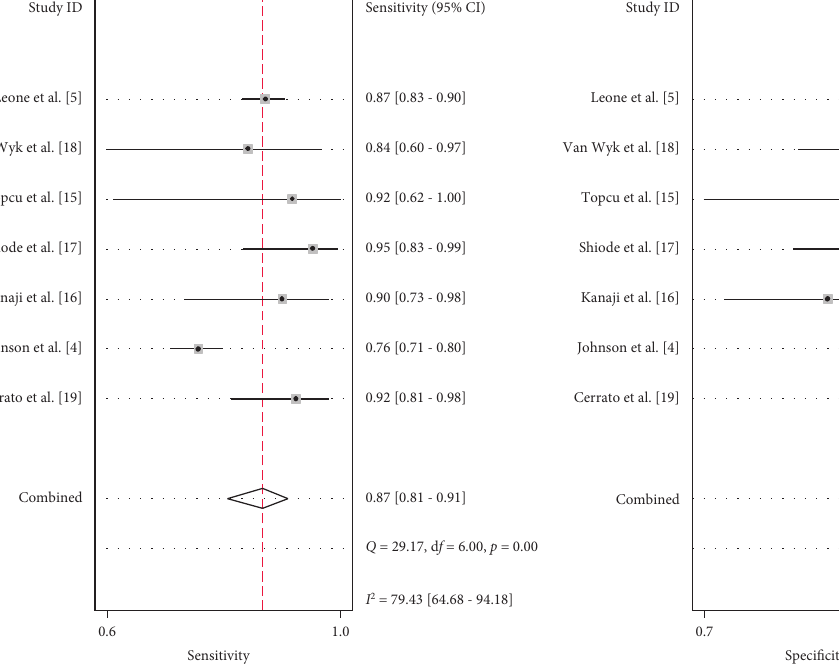
Figure 2: Forest plots for sensitivity and specificity of cFFR. CI: confidence intervals.